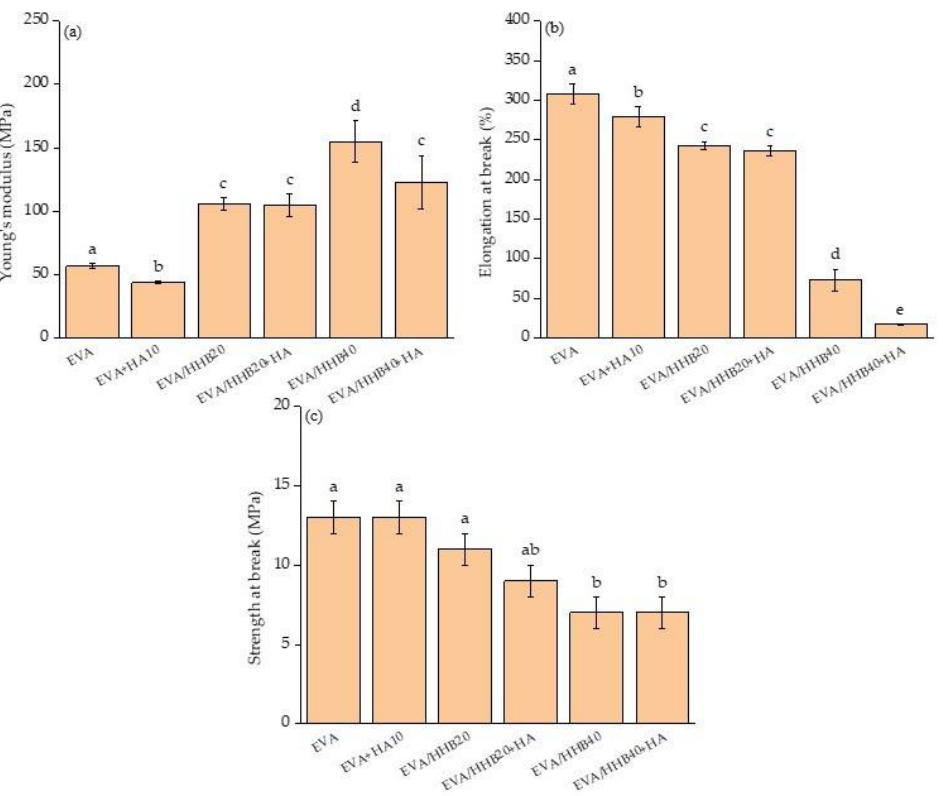
Figure 8. ( a ) Young’s modulus, ( b ) elongation at break, and ( c ) strength at break of unfilled EVA and its composites. Data annotated with different letters are significantly different (at 95% confidence level).